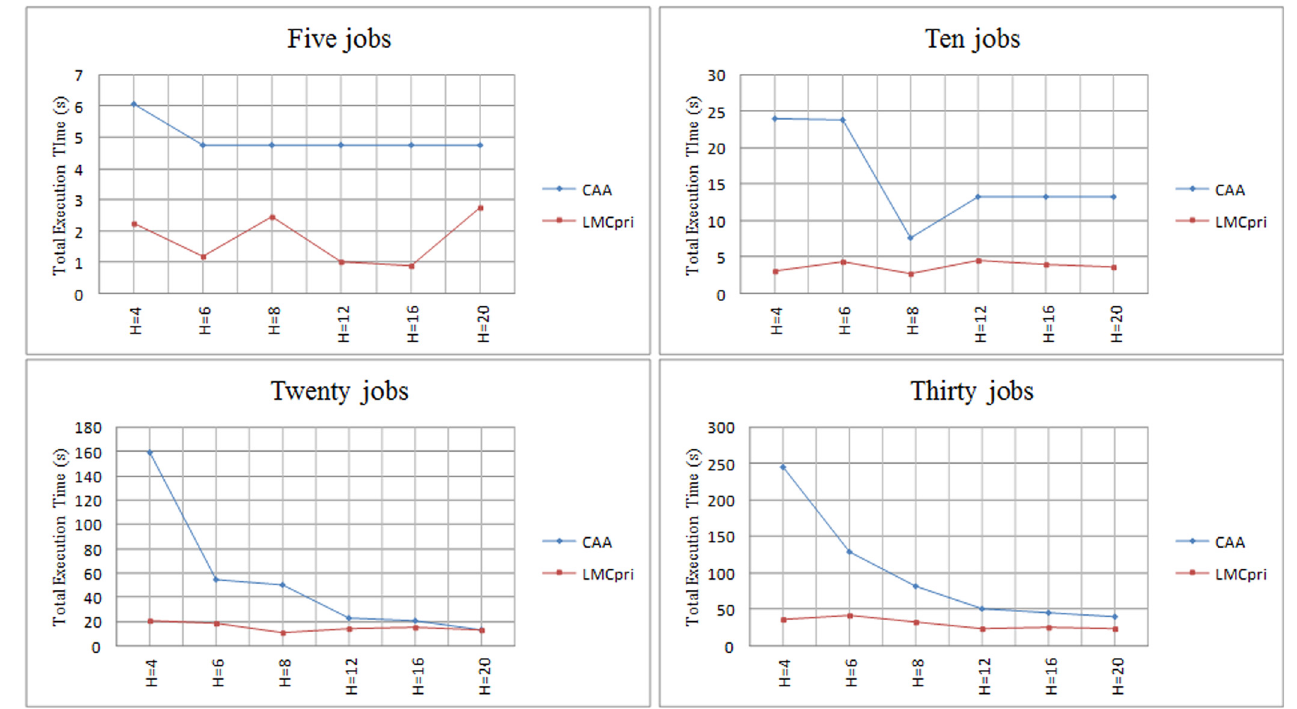
Fig 11. Comparing total execution time of LMCpri and cloud assisting architecture (CAA). H means the number of helpers in x-axis.